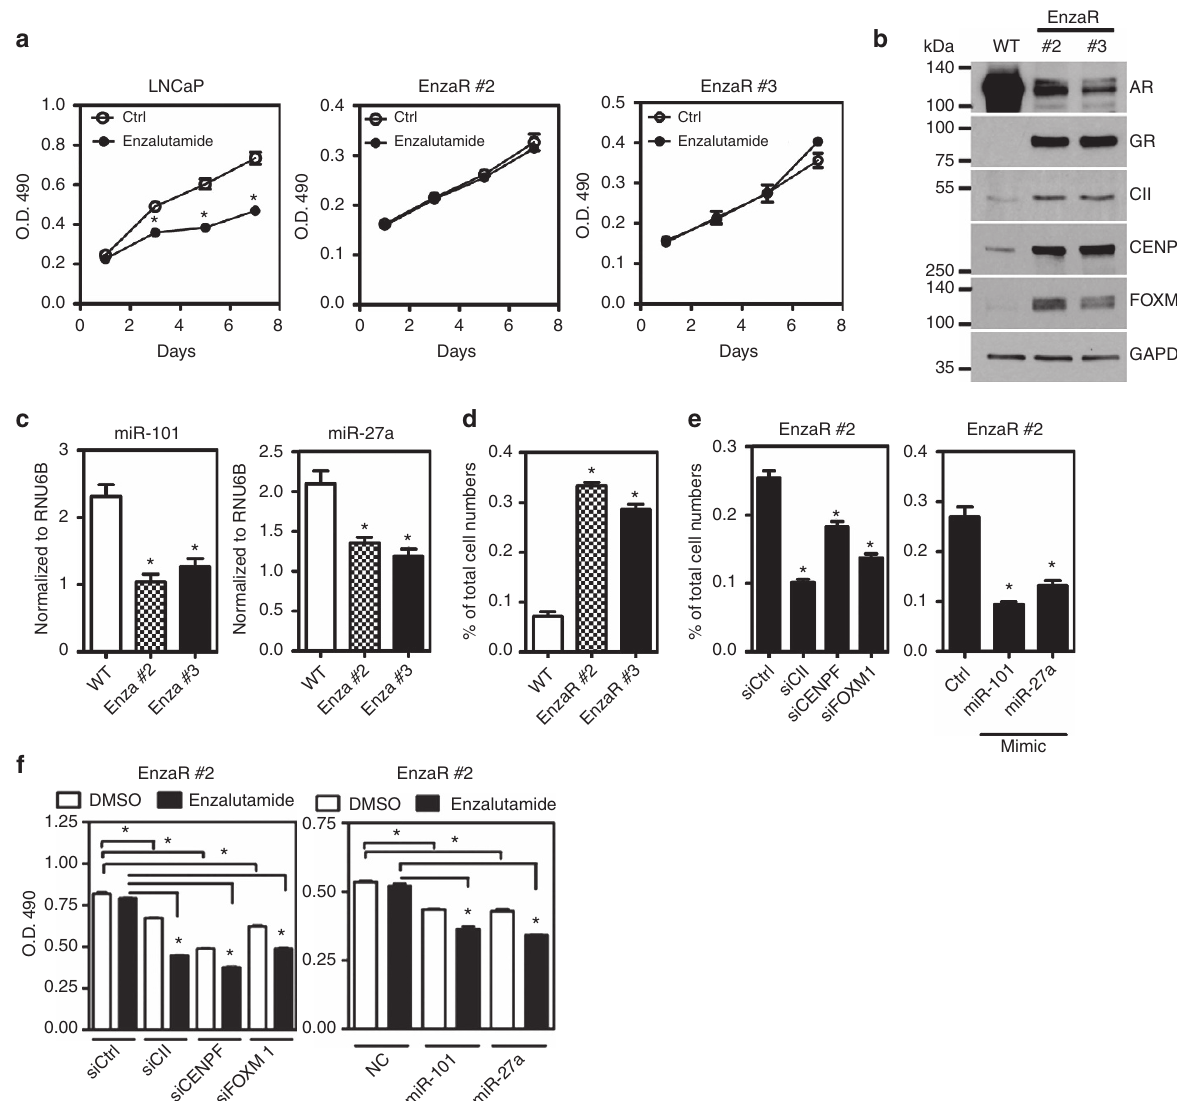
Figure 7 | miRNA-COUP-TFII-CENPF-FOXM1 regulation axis contributes to the enzalutamide resistance. ( a ) Parental cell (LNCaP) and enzalutamide- resistant (EnzaR) clones were treated with 10 m M enzalutamide for indicated time point and cell growth was measured by MTS assay ( n ¼ 3). * P o 0.001 (two-way ANOVA test). ( b ) A representative western blot shows the expression of COUP-TFII, CENPF, FOXM1, AR and GR (glucocorticoid receptor), a positive control gene for enzalutamide-resistant clones 44 . ( c ) RT-real-time PCR data demonstrated the expressions of miR-101 and miR-27a in LNCaP (WT) and EnzaR clones ( n ¼ 3). * P o 0.05 (one-way ANOVA followed by Dunnett test). ( d ) LNCaP (WT) and EnzaR cells were used to perform migration chamber assay for 16h ( n ¼ 3). Then, invaded cells were counted and normalized to total cell number. * P o 0.0001 (one-way ANOVA followed by Dunnett test) ( e , f ) Knockdown of COUP-TFII, CENPF or FOXM1, or overexpression of miR-101 or miR-27a in enzalutamide clone (#2) was used to perform migration chamber assay for 16h ( n ¼ 3). * P o 0.0001 (one-way ANOVA followed by Dunnett test) ( e ) or measure cell growth by MTS assay after treating with or without 10 m M enzalutamide for 3 days ( f ). * P o 0.0001 (one-way ANOVA followed by Dunnett test). ANOVA, analysis of